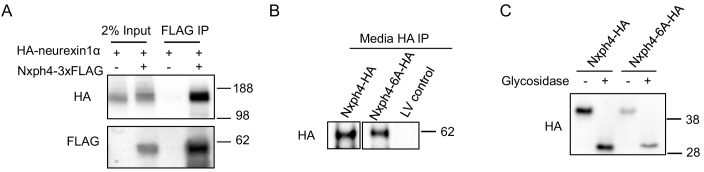
Nxph4 interacts with neurexin1α in vitro and the Nxph4-6A is secreted and glycosylated.(A) HA-neurexin1α and Nxph4-3xFLAG were co-expressed in HEK293T cells. Cell lysates were precipitated with beads conjugated with an anti-FLAG antibody. Bound proteins as well as input were analyzed by immunoblotting. (B) Media from primary cultured neurons over-expressing wild type and mutant Nxph4 was collected. After precipitation by beads conjugated with an anti-HA antibody, bound proteins were analyzed by immunoblotting. (C) Both wild type Nxph4 and Nxph4-6A showed similar reduction of molecular mass after glycosidase treatment.